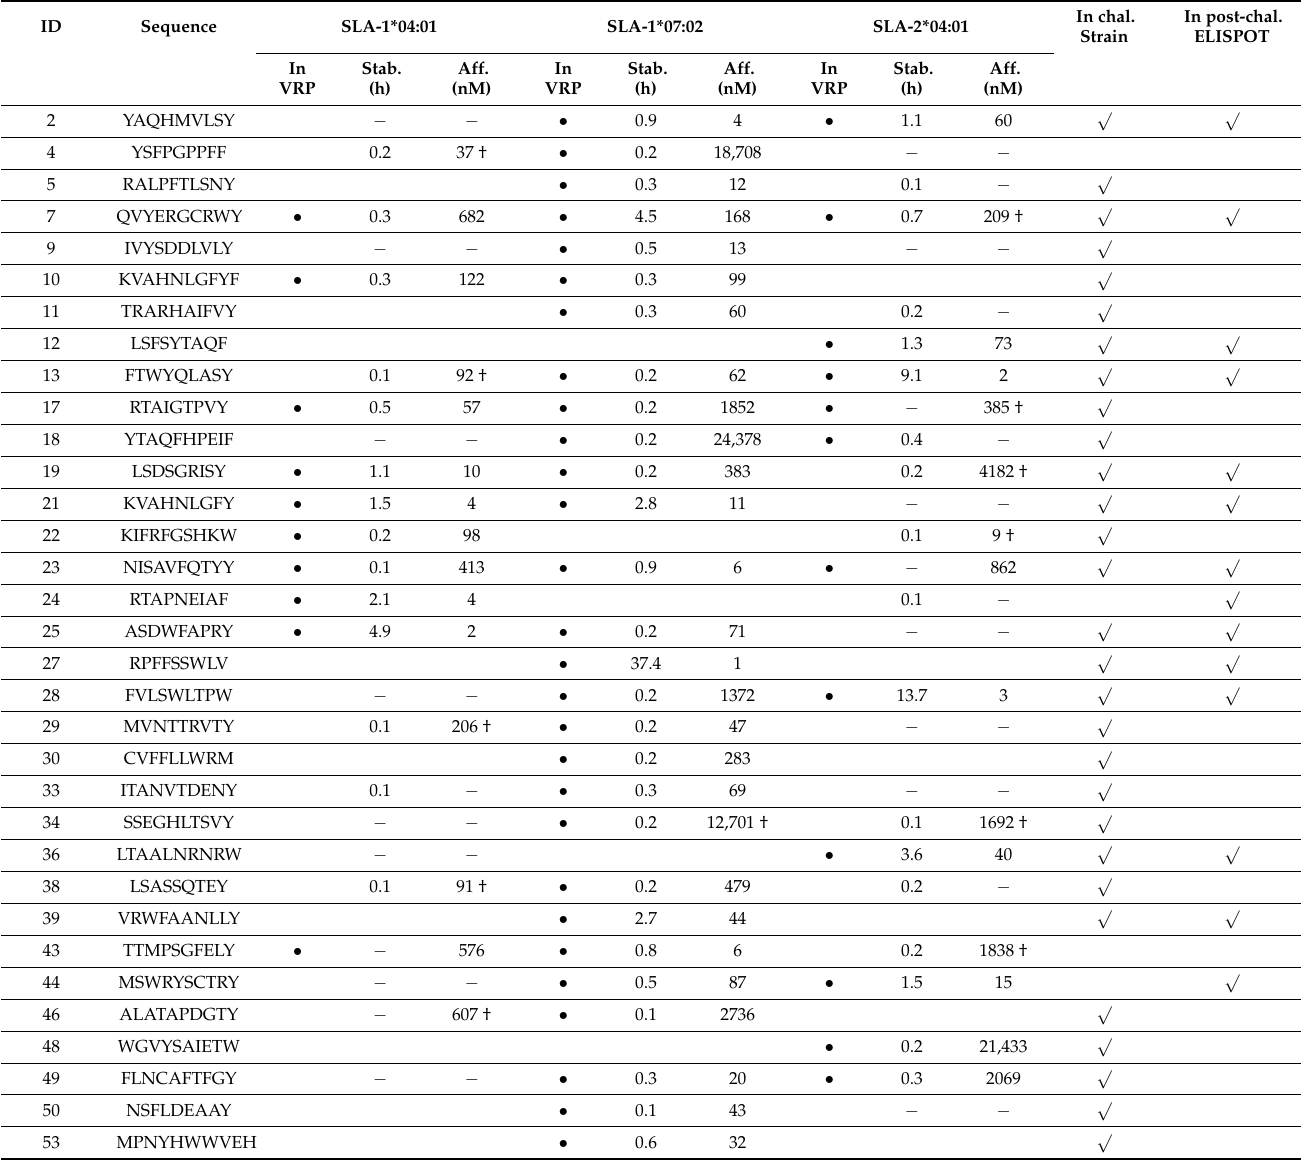
Table 2. Peptides included in the VRPs, in post-challenge ELISPOT, and naturally expressed by the challenge strain. ID